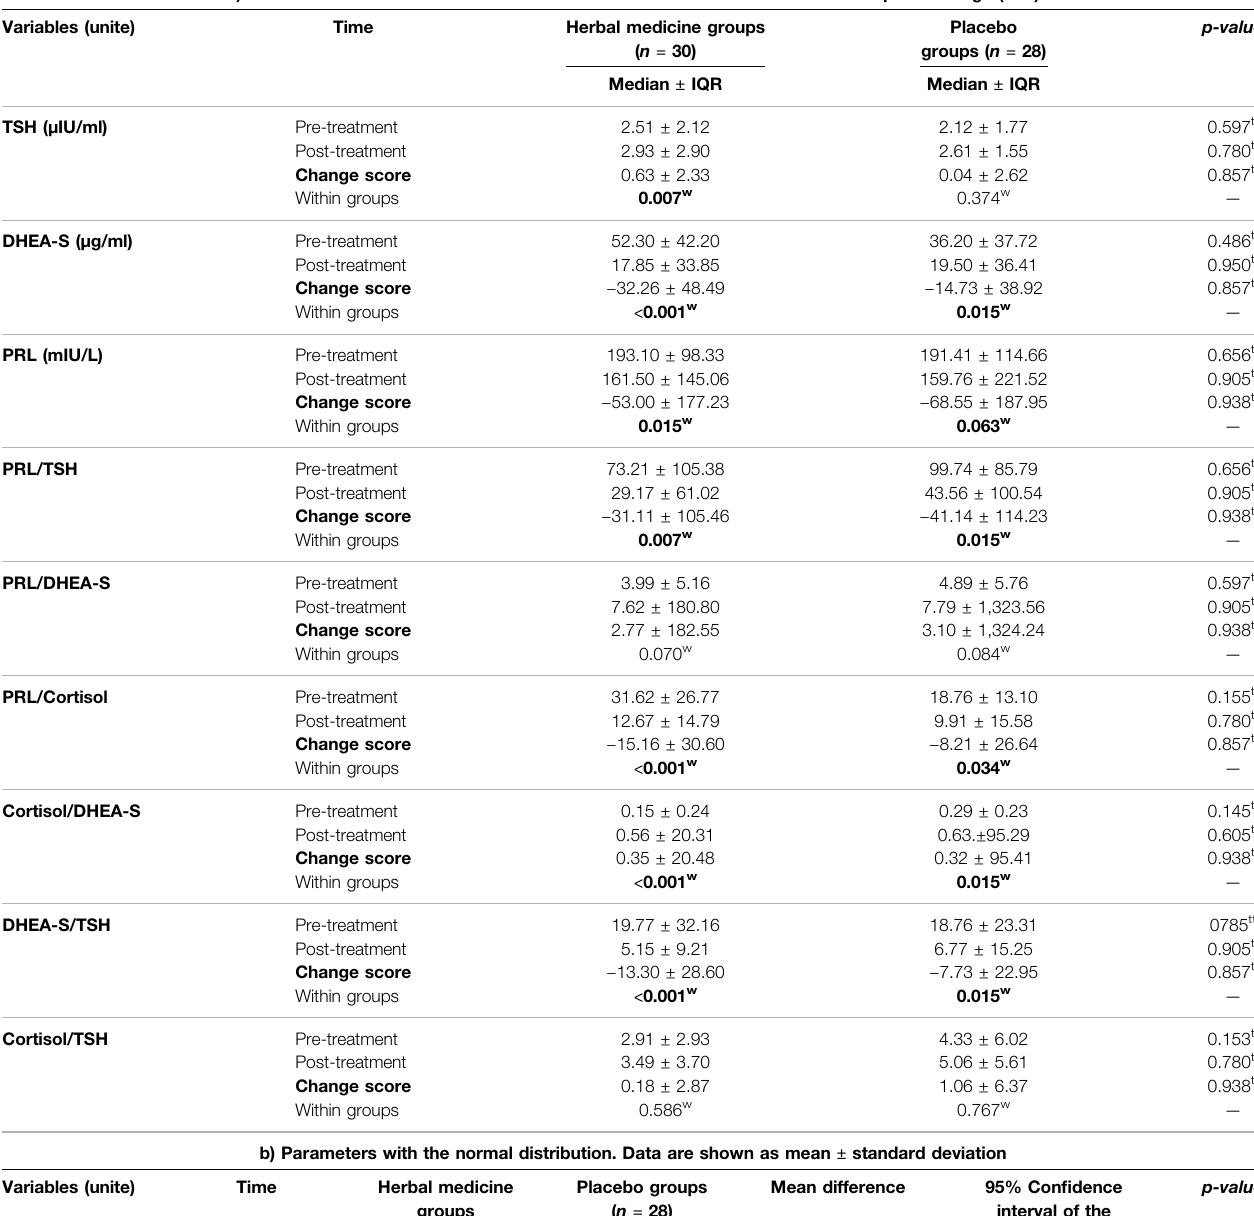
TABLE 3 | Comparison of the levels of thyroid-stimulating hormone (TSH), dehydroepiandrosterone-sulfate (DHEA-S), prolactin (PRL), and cortisol and their ratios between the two study groups. a) Parameters with non-normal distribution. Data are shown as median ± interquartile range (IQR) Variables (unite)